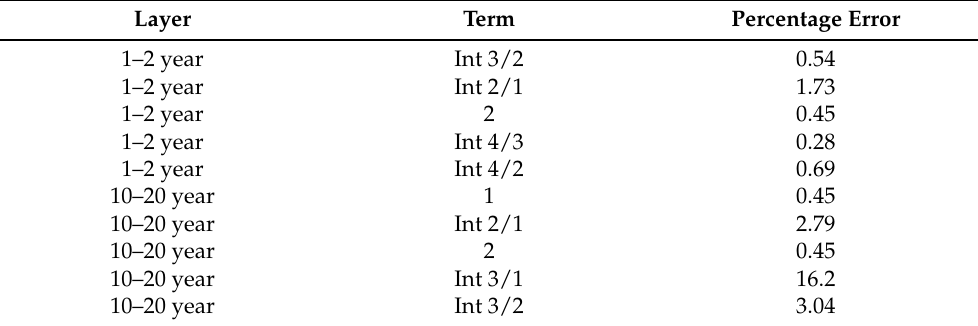
Table 8. A selection of post-catXL variance contribution term standard errors for S = 100 K simulation years (corresponding to the results displayed in Figure 9). Column 1 provides the Layer, Column 2 provides the type of term, and Column 3 contains the percentage error.